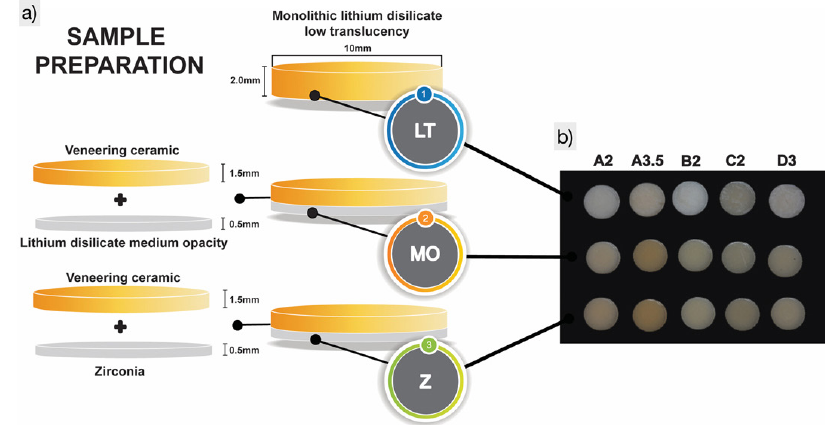
Figure 1- a) Schematic diagram of the specimen preparation; b) Specimens under standardized laboratory